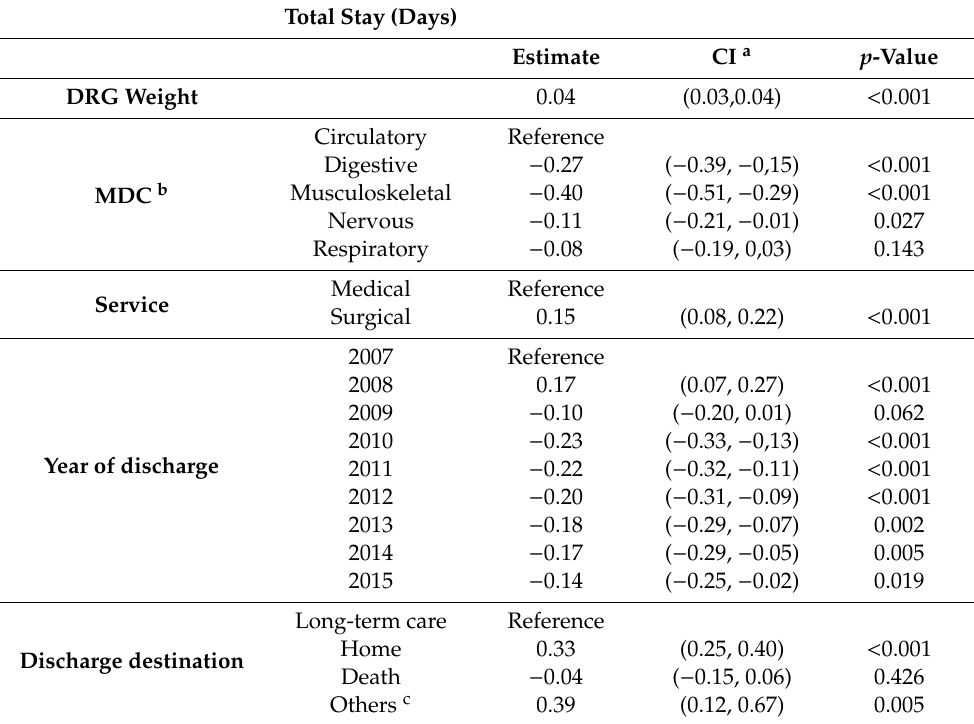
Table 3. Multivariate analyses. Cantabria (Northern Spain),